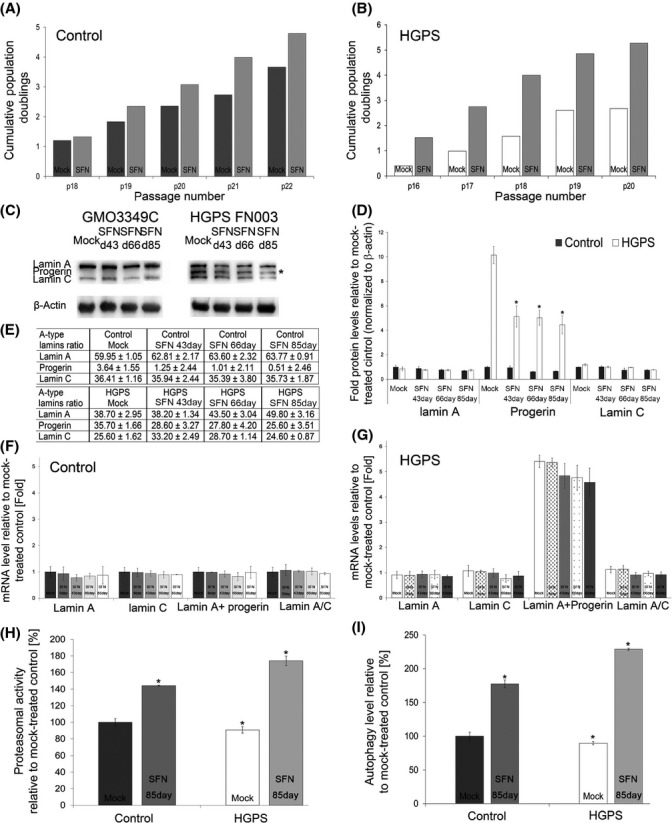
Effect of sulforaphane (SFN) on long-term control and Hutchinson–Gilford progeria syndrome (HGPS) fibroblast cultures. (A) Long-term cultures of control (GMO3349C and GMO1651C) and (B) HGPS (HGADFN127 and HGADFN003) cells that were mock treated or treated with SFN (1 μm). The cumulative population doubling was calculated at each indicated passage as described in the Procedures. (C) Western blot evaluation of A-type lamin (lamin A, lamin C, and progerin) levels in control and HGPS cells that were mock treated or treated with SFN every 2 days for the period indicated (a representative image is shown: n = 3). Blots were probed with antibodies against lamin A/C and β-actin. (D) Densitometric analysis of lamin A, lamin C, and progerin signals. Data represent the mean ± SD with respect to mock-treated control cells after the values were normalized to the β-actin signal (n = 3). (E) The proportions of lamin A, progerin, and lamin C were determined within each sample analyzed by Western blotting with anti-lamin A/C antibody as shown in (C). (F and G) The mRNA levels of the indicated proteins in total mRNA preparations isolated from normal (F) and HGPS (G) cells were determined using real-time PCR. Cells were either mock treated or treated with 1 μm SFN every 2 days for the period indicated. All values are presented as the mean ± SD (P < 0.05; n = 3). (H) Proteasome activity was defined by measuring chymotrypsin-like proteasome activity in the same cells as in (A) using Suc-LLVY-AMC as a substrate. Cells were either mock treated or treated with 1 μmSFN, every 2 days for 85 days as indicated. The percentage of activity was calculated relative to mock-treated control. Data are expressed as the mean ± SD (*P < 0.05; n = 3). (I) The same cells and culture conditions as in (H) were used to determine autophagy activity by measuring monodansylcadaverine (MDC) levels by fluorescence photometry, as described in the Methods. Data are presented as the mean ± SD (*P < 0.05; n = 3).